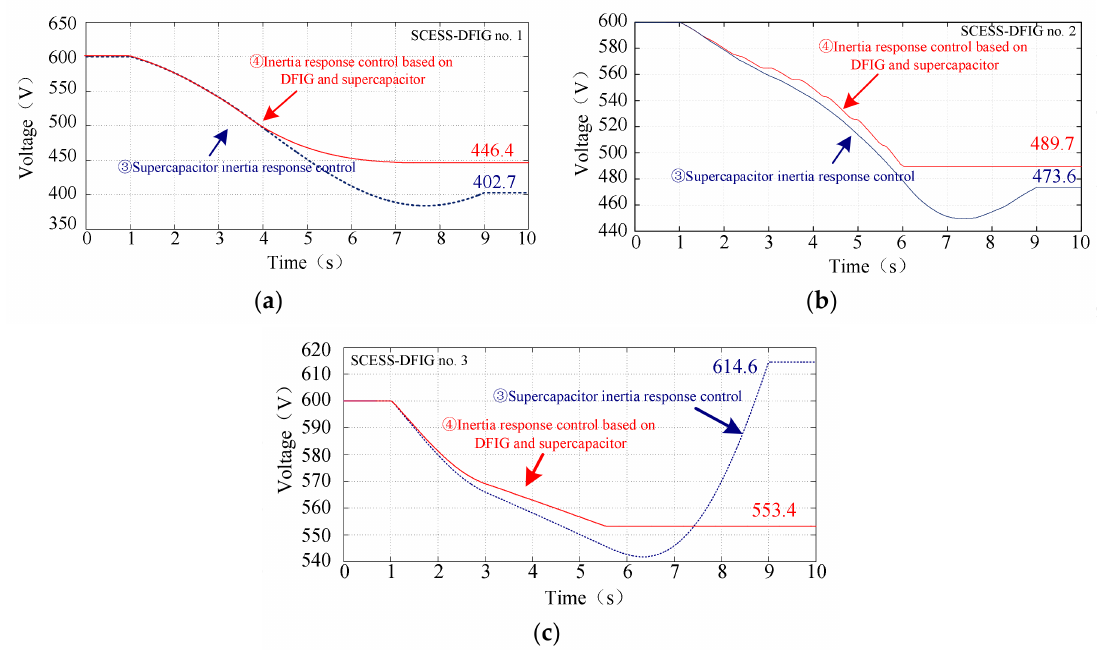
Figure 21. Comparison of SCESS-DFIG supercapacitor voltages under different control strategies: ( a ) No. 1 SCESS-DFIG supercapacitor voltage under different control strategies; ( b ) No. 2 SCESS-DFIG supercapacitor voltage under different control strategies; ( c ) No. 3 SCESS-DFIG supercapacitor voltage under different control strategies.